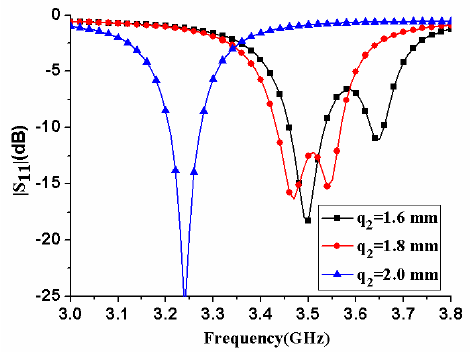
Figure 8. | S 11 | of the antenna element with di ff erent size q 2 Figure 8. |S 11 | of the antenna element with different size q 2 . Figure 8. |S 11 | of the antenna element with different size q 2 . Figure 8. |S 11 | of the antenna element with different size q 2 .